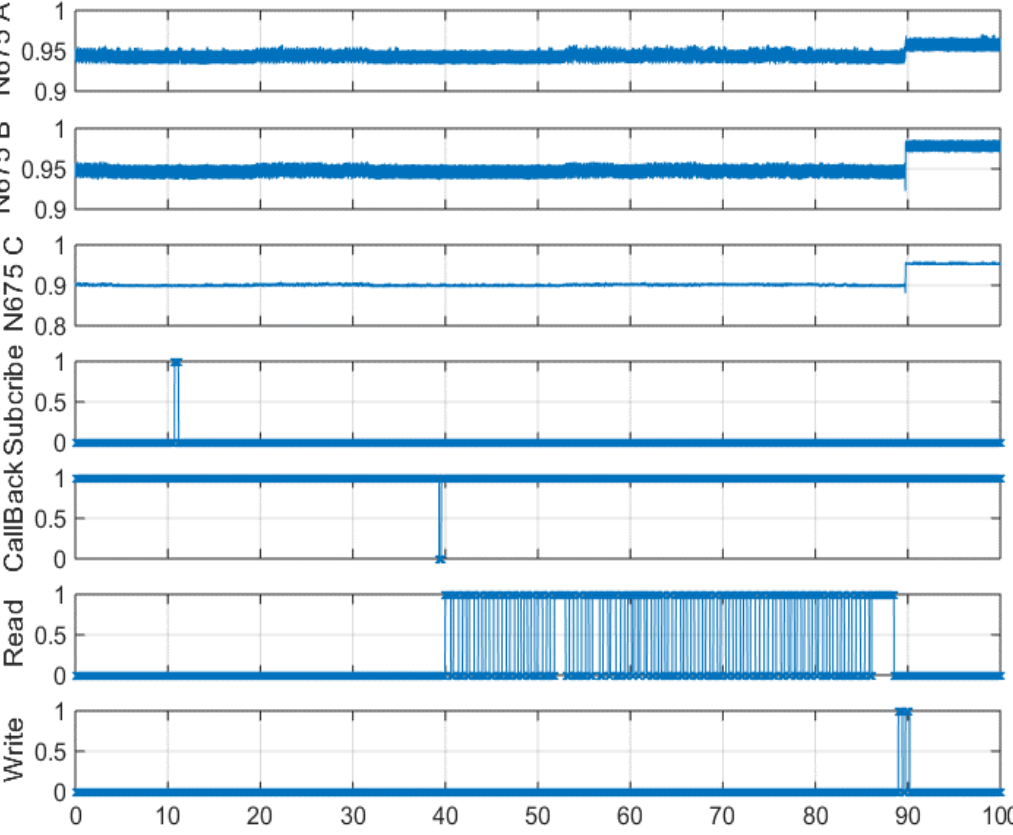
Figure 5. Interaction between agents and the real ‐ time simulation and the effects of control actions on the voltage at node 675.